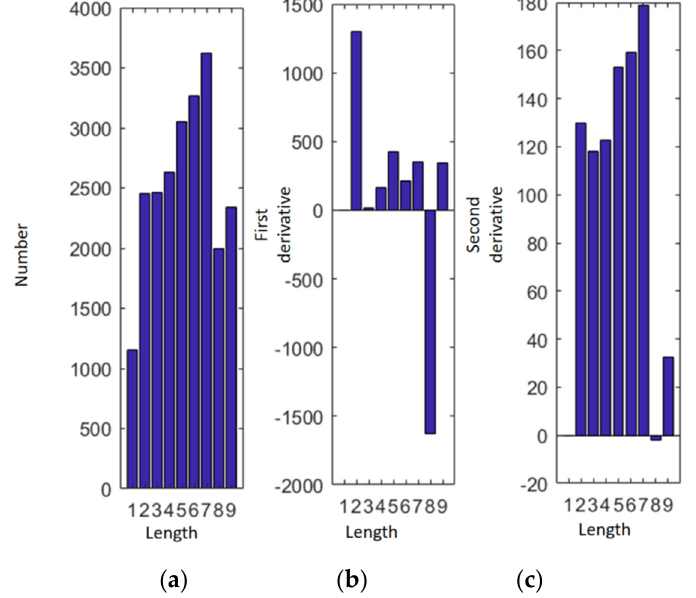
Figure 20. Number change of point clouds in a certain area and its first and second derivatives. Note: number change ( a ); first derivative ( b ); second derivative ( c ).